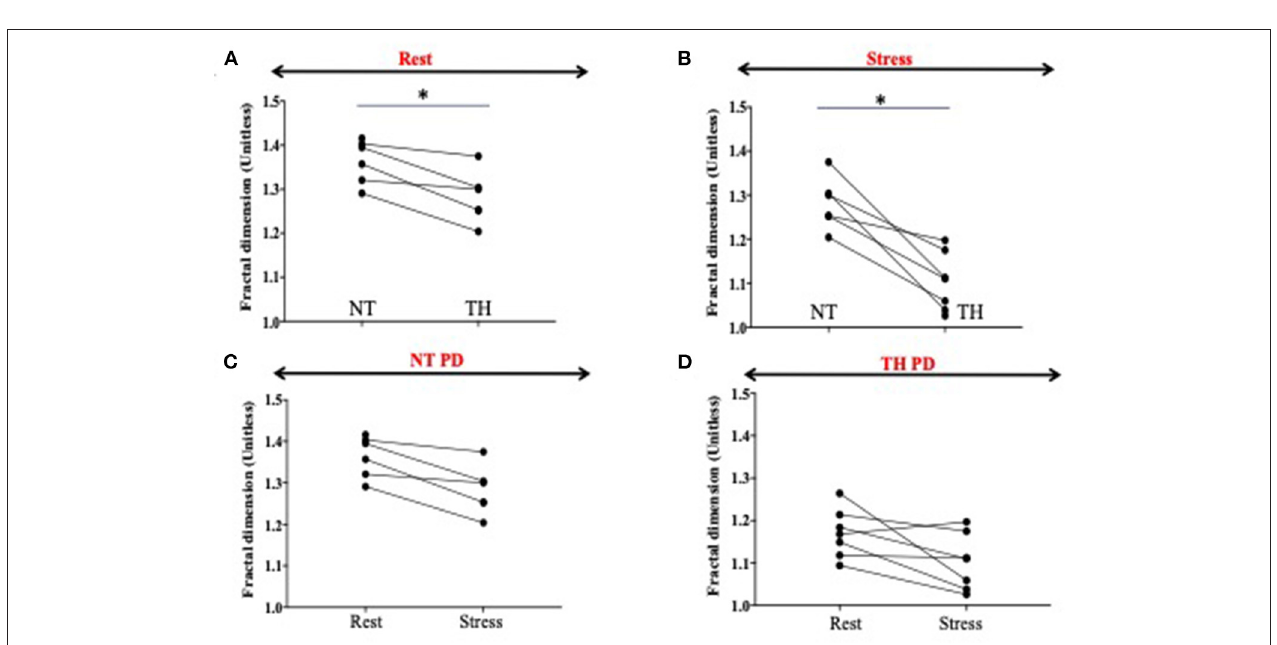
FIGURE 4 | Fractal dimension as surrogate of heterogeneity. Fractal dimensions (FD) is a strong measure of blood flood (BF) heterogeneity, where BF = 1.5 means a complete heterogeneity and BF = 1a homogeneity in perfusion. (A,B) Heterogeneity is significantly decreased ( − 14%, p = 0.03) at rest in the therapeutic hypothermia (HT) group compared to the normothermic (NT) group. We showed also a significant decrease of heterogeneity during the stress ( − 14 %, p = 0.03) in the HT compared to the NT group. (C,D) We showed a significant decrease of heterogeneity between rest and stress only in the HT group ( − 6%, p = 0.04). The * represents